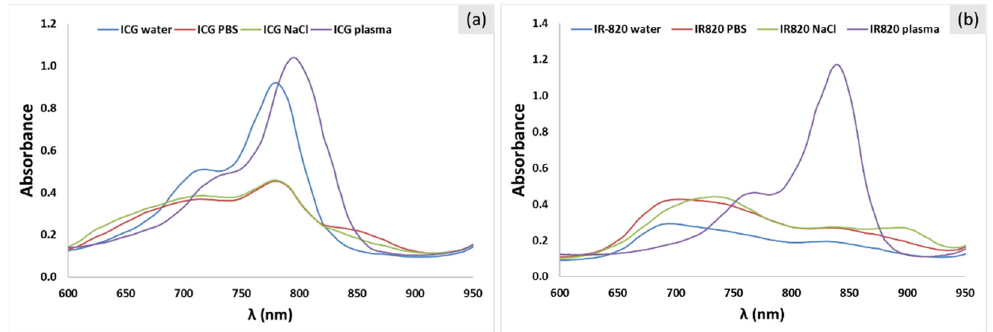
Figure 2. Absorption spectra of ( a ) ICG and ( b ) IR-820 in water, PBS buffer, 0.9% NaCl(aq), and blood plasma. The dye concentration is 10 μ g/mL in all cases.